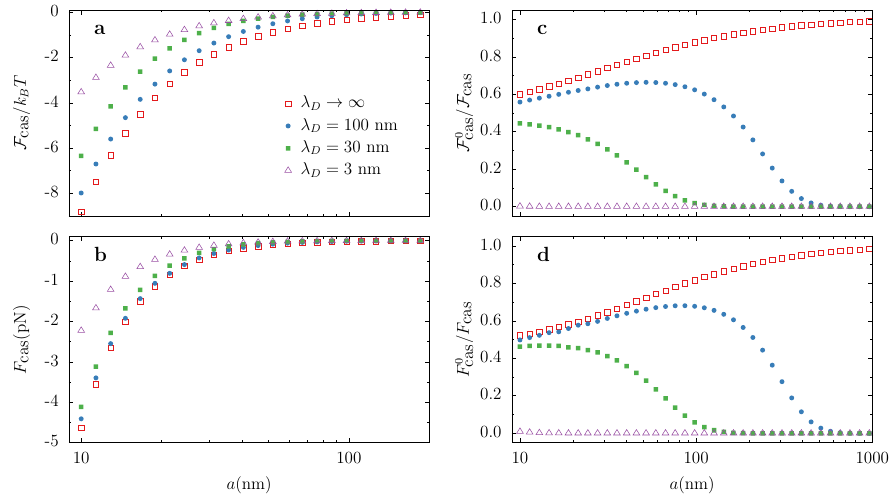
Figure 2. Variation with the surface-to-surface distance of the ( a ) Casimir free energy, ( b ) Casimir force, ( c ) relative zero frequency contribution to the free energy, and ( d ) relative zero frequency contribution to the force. We consider two PS spheres of radius 1 µ